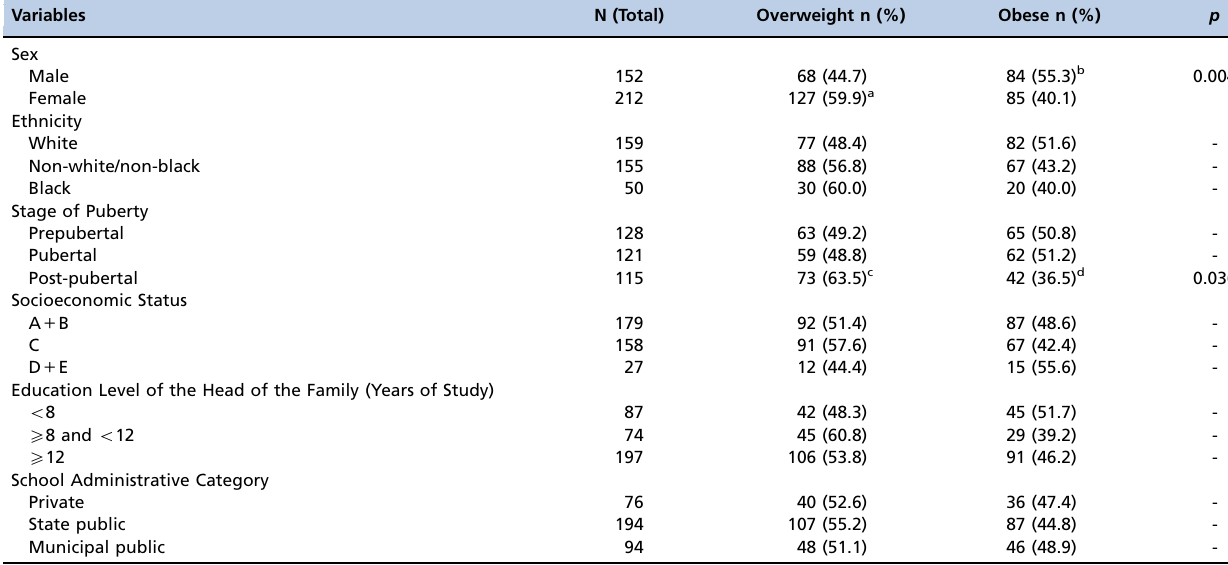
Table 1 - Prevalence rates of overweight and obesity grouped according to demographic and socioeconomic variables. Variables N (Total)